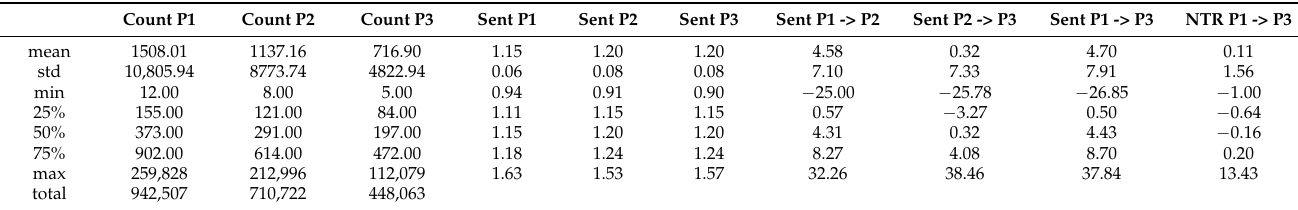
Table 6. Sentiments and their changes (in percentage points) per ward over time periods. Sent = Sentiment, P = time period, NTR = negative Tweet ratio.